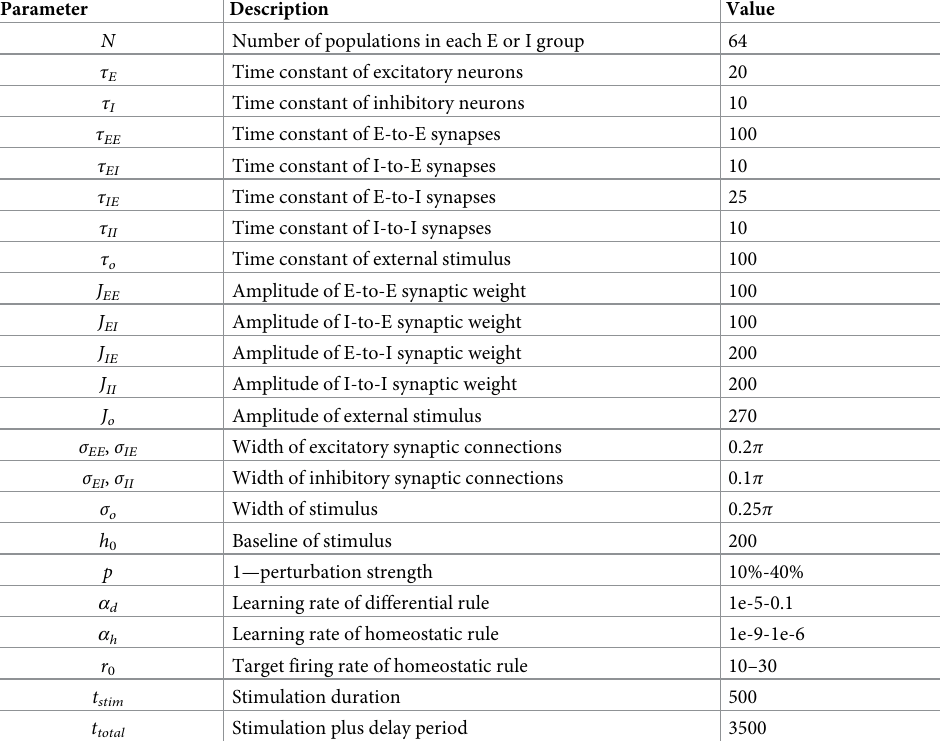
Table 1. Parameters for spatially structured